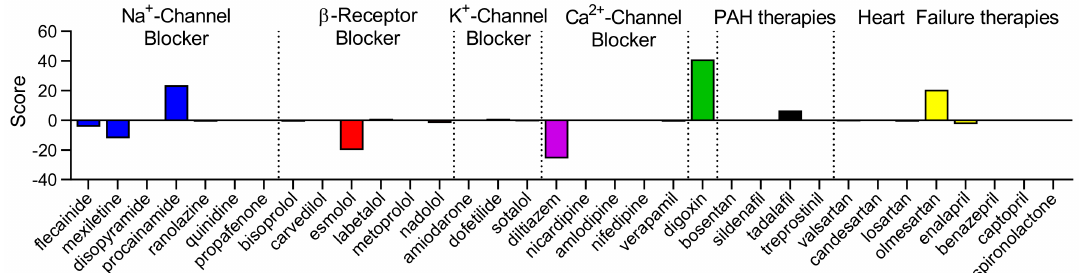
Figure 3. Screening of channelome against pharmacological perturbagens tested in human cell lines (CMap). Graph showing connectivity scores of DEGs from RV-D versus RV-CTRL to common anti-arrhythmic drugs (Na + —channel blockers, β —receptor blockers, K + —channel blockers, and Ca 2+ —channel blockers), and PAH and heart failure therapies. Negative or positive score predicts anti- or pro-arrhythmic potential, respectively. Connectivity score scale − 100 to